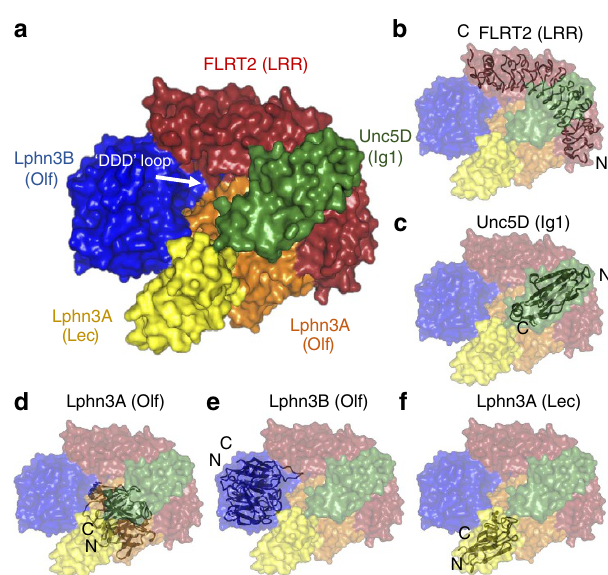
Figure 3 | Crystal structure of the tetrameric complex of FLRT2 LRR and Unc5D Ig and Lphn3 Lec-Olf . ( a ) The protein chains in the structure are coloured FLRT2 LRR (red), Unc5D Ig (green), Lphn3A Lec–Olf (Olf: orange, Lec: yellow), Lphn3B Lec–Olf (Olf: blue). The Lec domain of Lphn3B is not resolved in the crystal structure, and is presumably flexible within the crystal. The location of the DDD loop in Lphn3B is indicated. ( b – f ) Individual domains are shown as black cartoons within the surface model of the complex. The locations of N and C termini are indicated. See also Supplementary